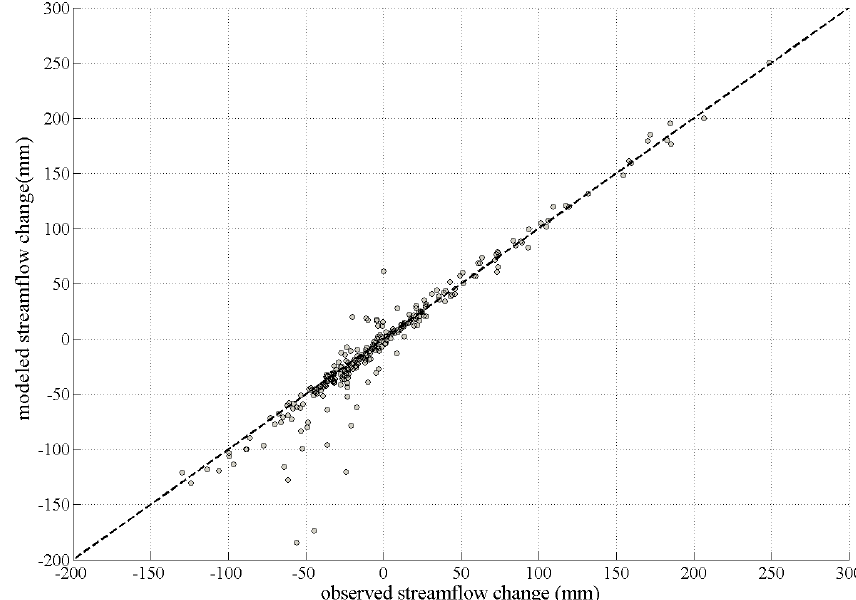
Figure 6. Comparison between observed and calculated mean annual runoff